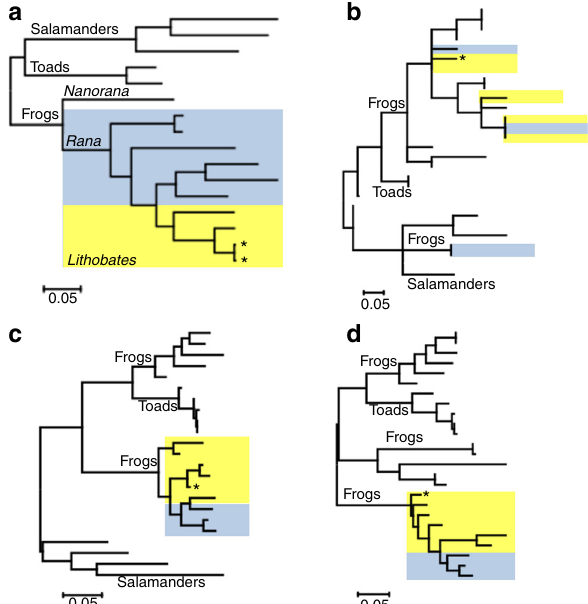
Fig. 2 Molecular phylogenetic analysis of amphibian mitochondrial genomes and genes. The phylogenetic tree is drawn to scale, with branch lengths measured in the number of substitutions per site. The analysis involved a complete mitochondrial (Mt) genome sequences of salamanders, toads and frogs, classi fi ed as Rana (blue highlight) or Lithobates (yellow highlight). Analysis of Mt genes b cyb , c rnr1 , and d rnr2 of selected frog species. Position of R. catesbeiana indicated by an